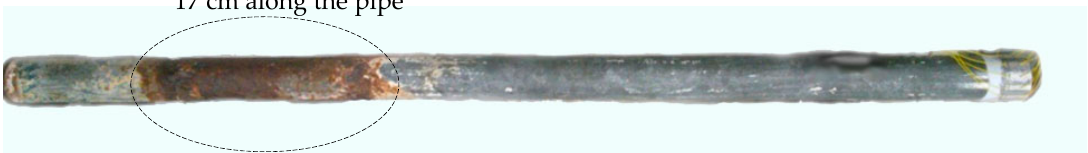
Figure 2. Steel pipe with natural corrosion.